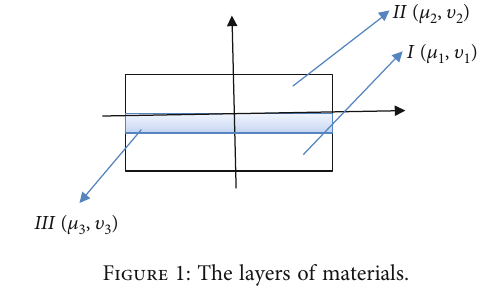
Figure 1: The layers of